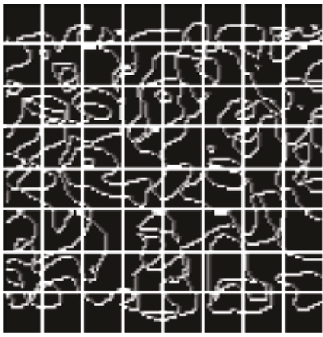
Figure 3: A sample of LGPP divided into 64